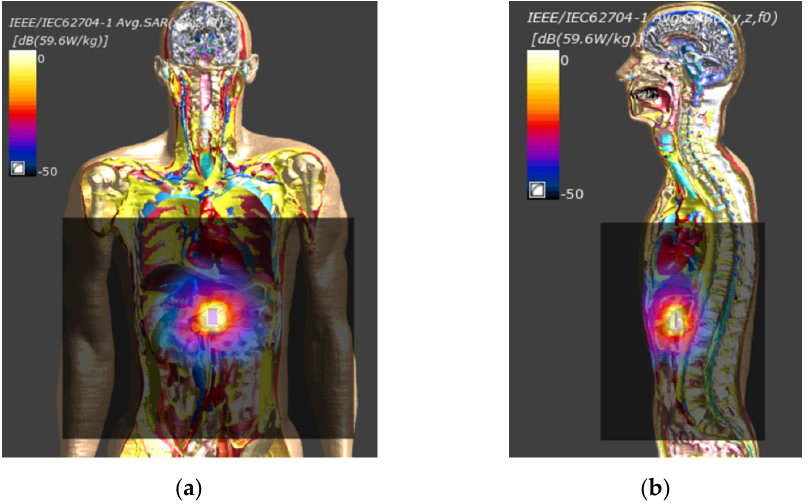
Figure 24. Spatial distribution of SAR for 10 g tissue mass at 402.5 MHz in the male anatomical model ( a ) front side ( b ) left side extracted from Sim4Life simulation software [16].